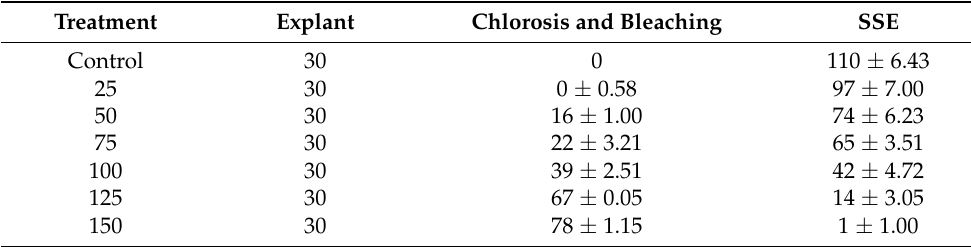
Table 1. The frequency of chlorosis and mean number of secondary somatic embryos (SSEs) per pri- mary SE in the selection medium with different concentrations of kanamycin after 40 days of culture. Treatment